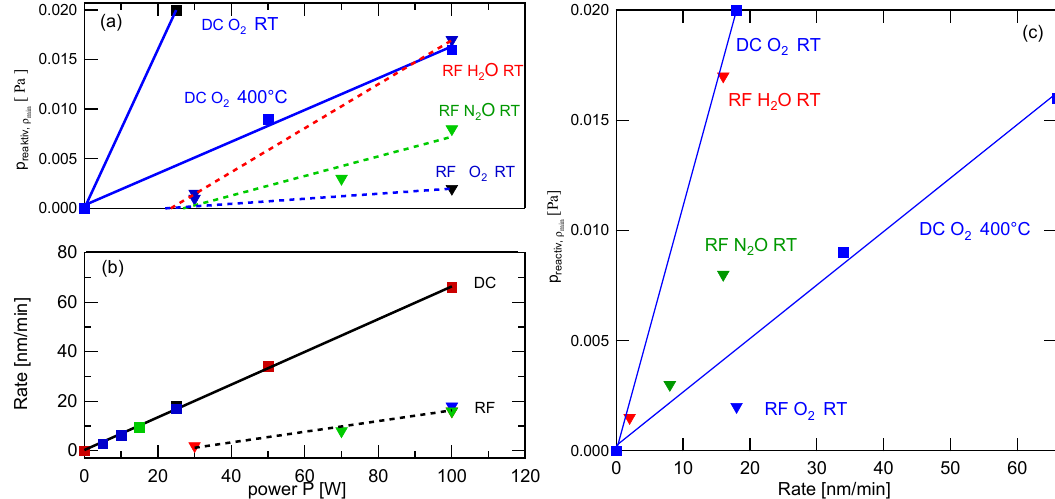
Figure 1. ( a ) Partial pressures of the reactive gases where the resistivity minimum was found as a function of the discharge power. ( b ) Deposition rate as a function of the discharge power for DC and RF (13.56 MHz) plasma excitation. Reactive gases used were O 2 , H 2 O and N 2 O. ( c ) Partial pressures of the reactive gases where the resistivity minimum was found as a function of the deposition rate. Deposition parameters: p total = 0.5 Pa; square / triangular symbols: DC / RF excitation; reactive gases: O 2 (blue), N 2 O (green), H 2 O (red); black fit lines: room temperature deposition (RT), red fit lines: 400 °C deposition.